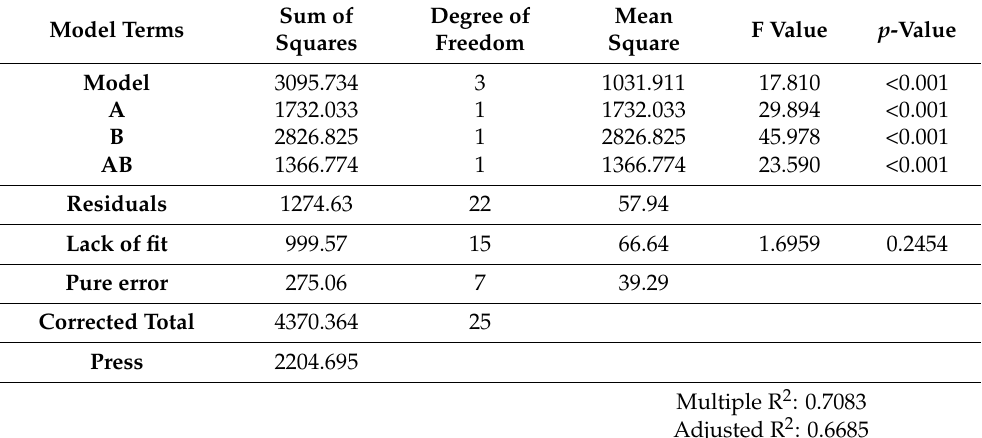
Table 2. ANOVA and regression analysis summary for the thin-walled tubes’ melt thickness. Sum Model Terms